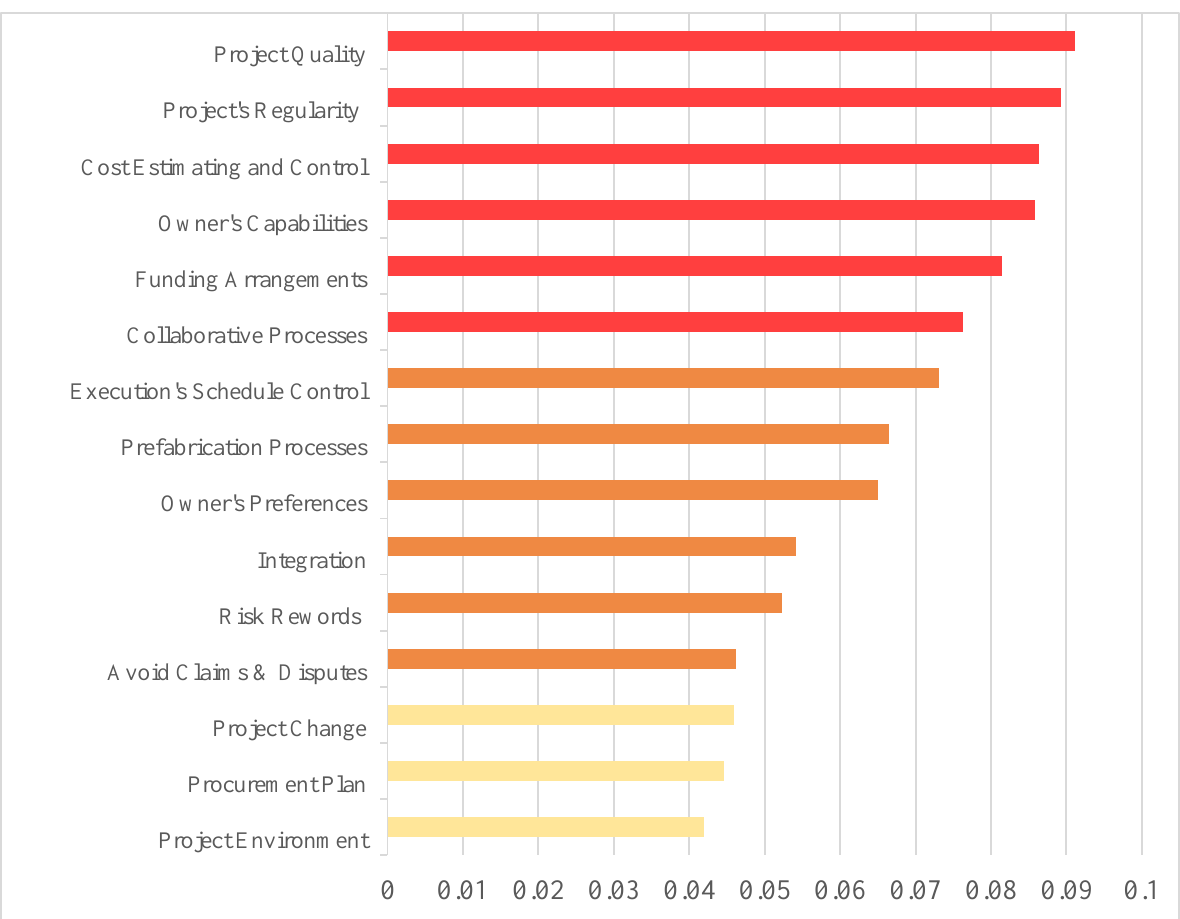
Figure 9. The global weights of subcriteria .